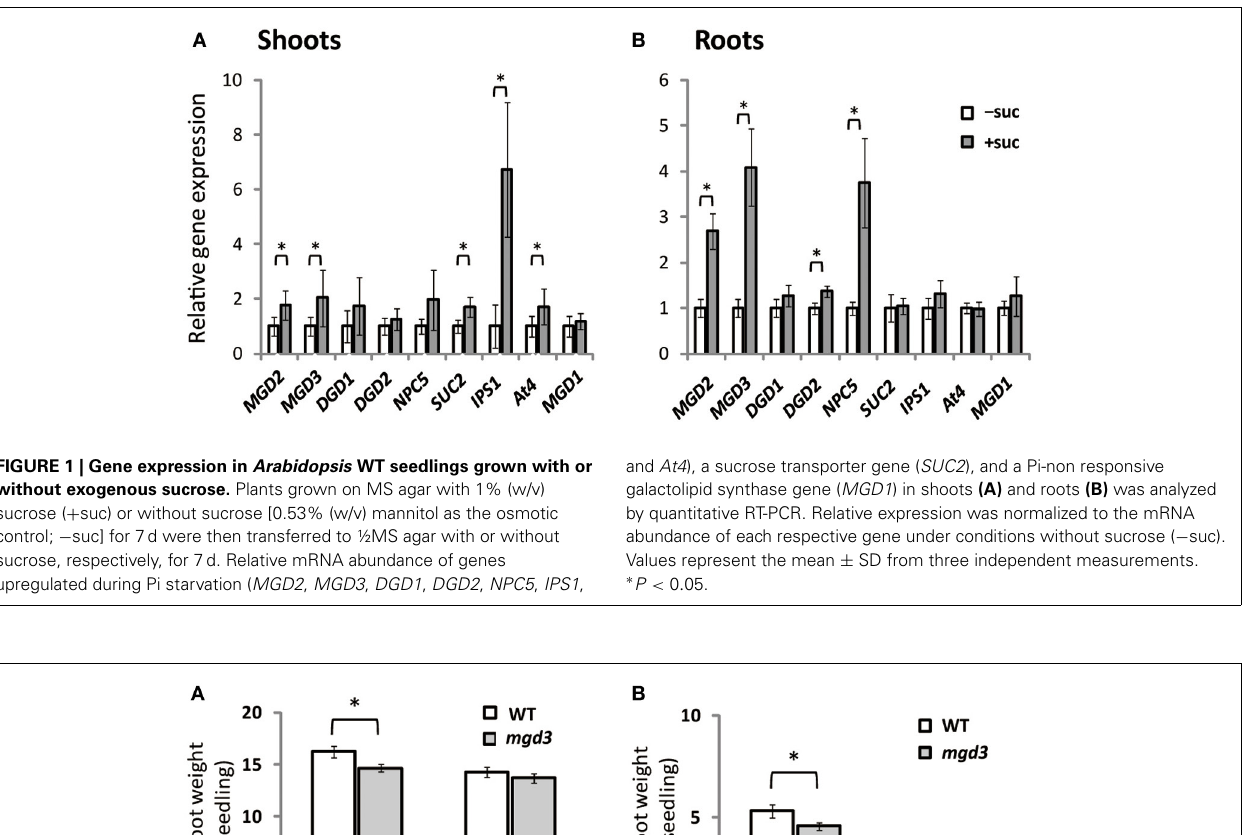
FIGURE 2 | Fresh weight of WT and the mgd3 mutant under conditions with or without exogenously supplied sucrose. Plants grown on MS medium supplemented with + suc or − suc for 7d were then transferred to